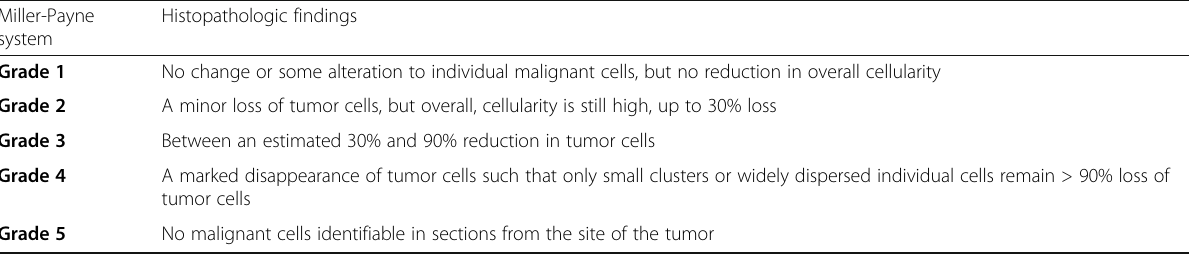
Table 2 Miller-Payne grading system for histopathologic response evaluation [14] Miller-Payne